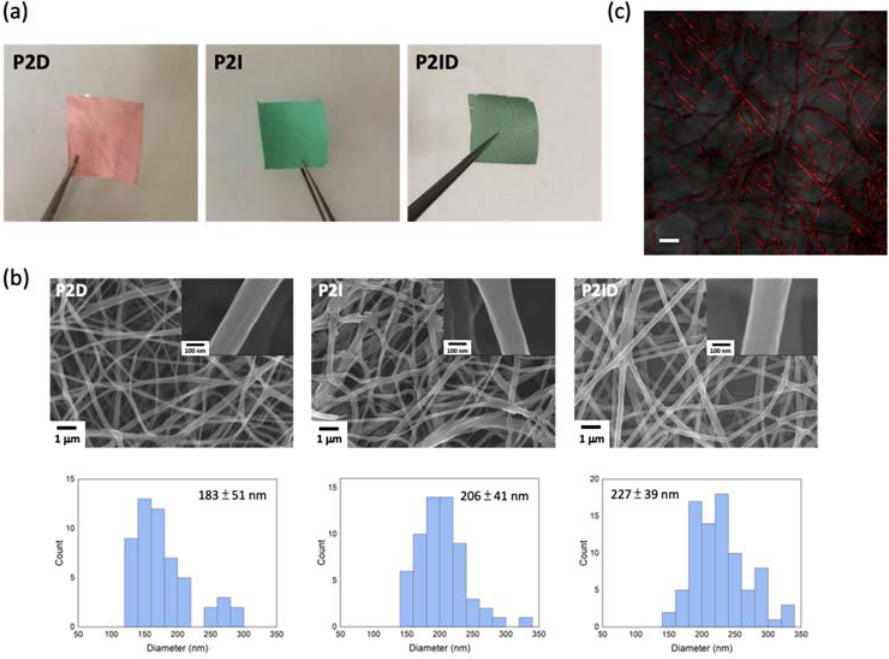
Figure 3. ( a ) Photographs of the P2D , P2I , and P2ID nanofibers. ( b ) FE-SEM images of the ICG and/or DOX loaded ES nanofibers. ( c ) Confocal images of P2ID nanofibers (scale bar is 2 μ m).